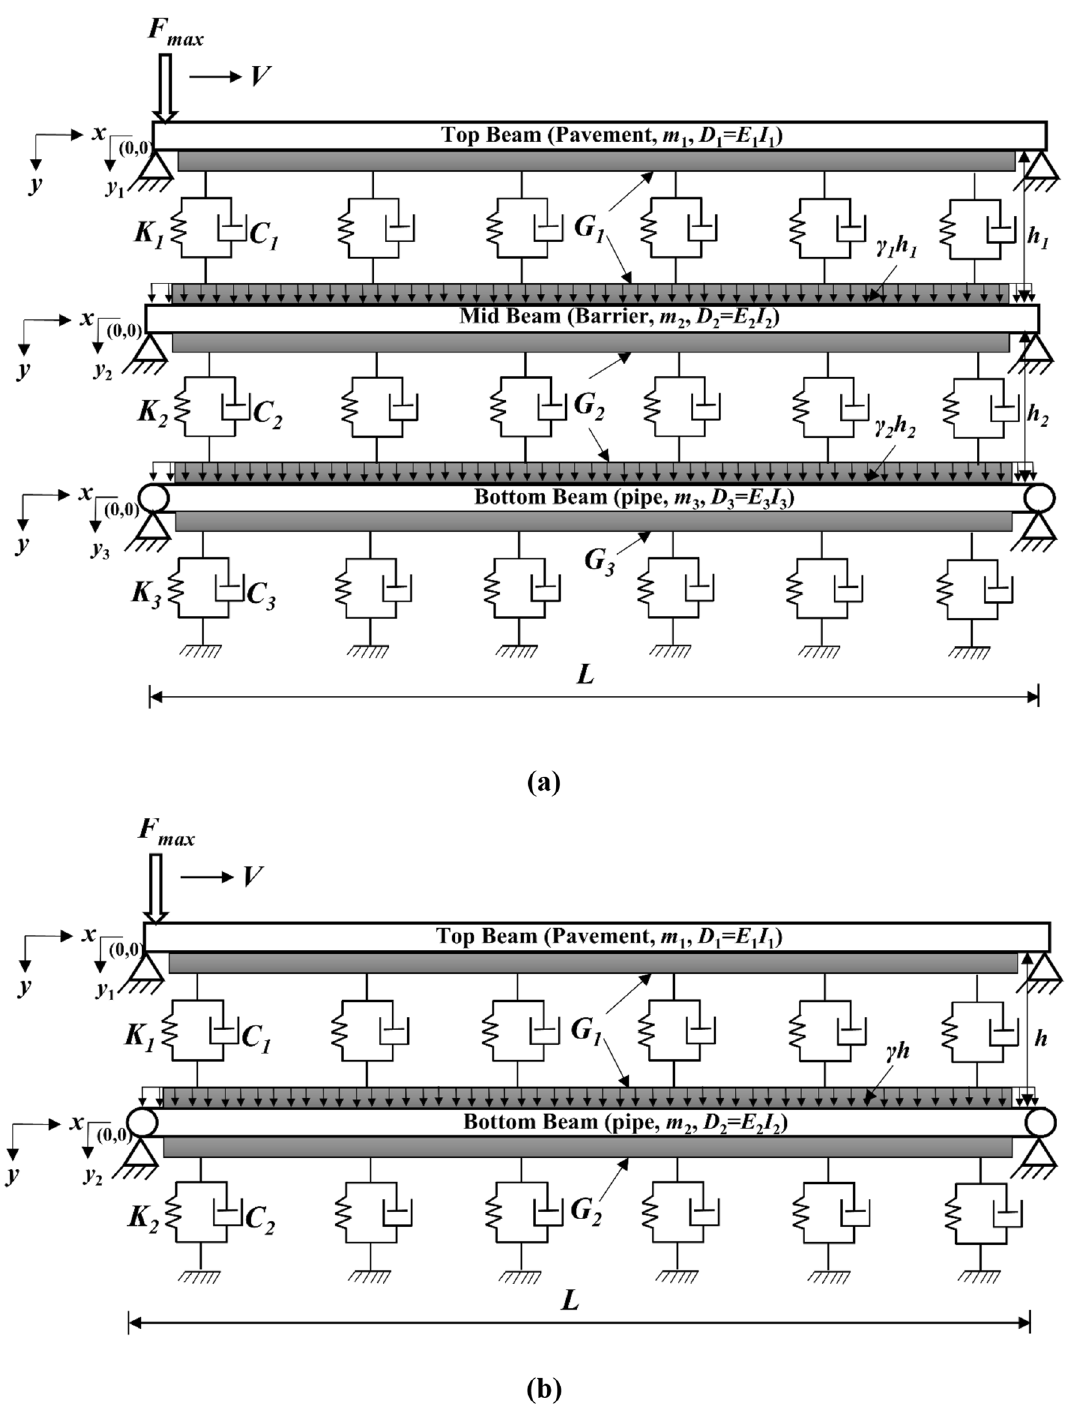
Figure 1. Analytical model of pipe below the pavement structure ( a ) with safeguard and ( b ) without